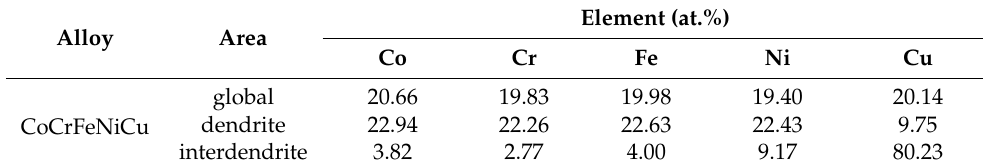
Figure 2. SEM images of CoCrFeNiCu alloy, magnification: ( a ) 1000 × , ( b ) 2000 × . Table 3. The chemical composition of CoCrFeNiCu high-entropy alloy.